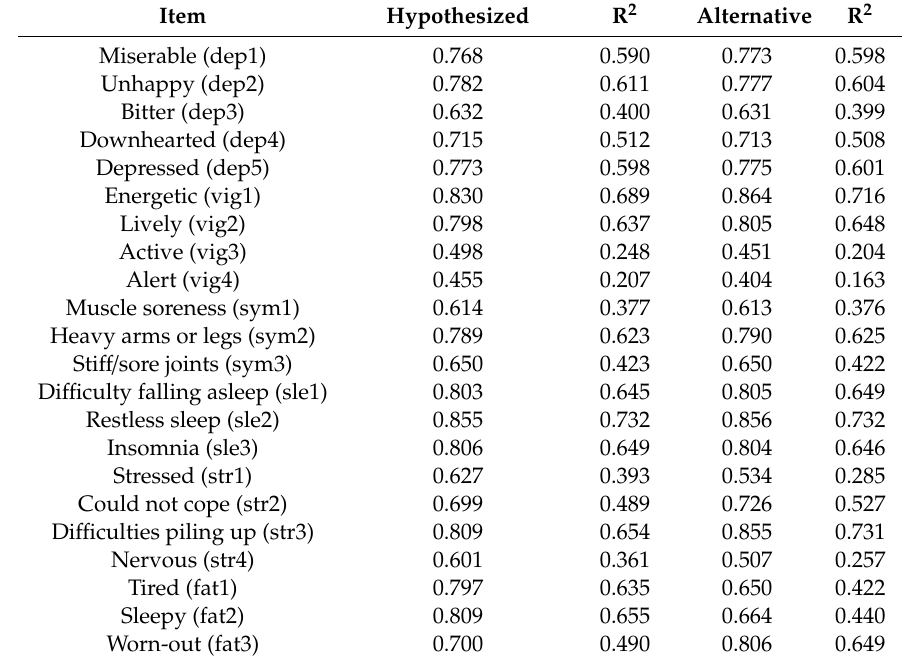
Table 6. Standardized factor loadings and R 2 values for each item in the questionnaire for the hypothesized model and the alternative model.